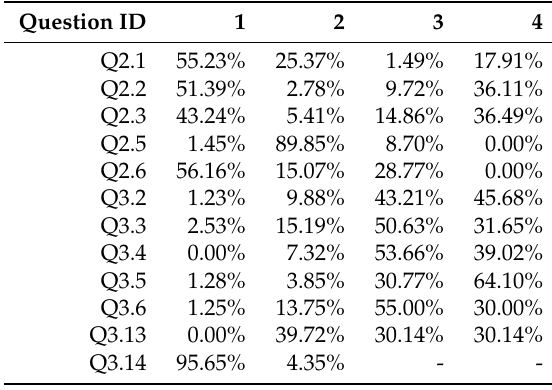
Table 9. Answers of the survey preformed during the CUnit (week 7—Q2 and week